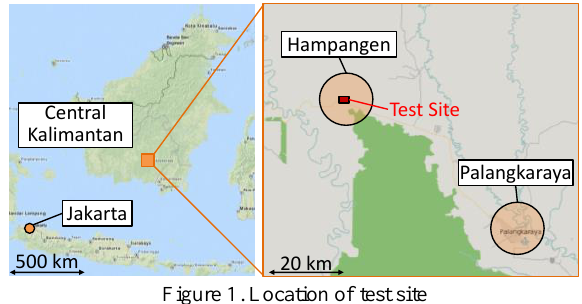
Figure 1. Location of test site